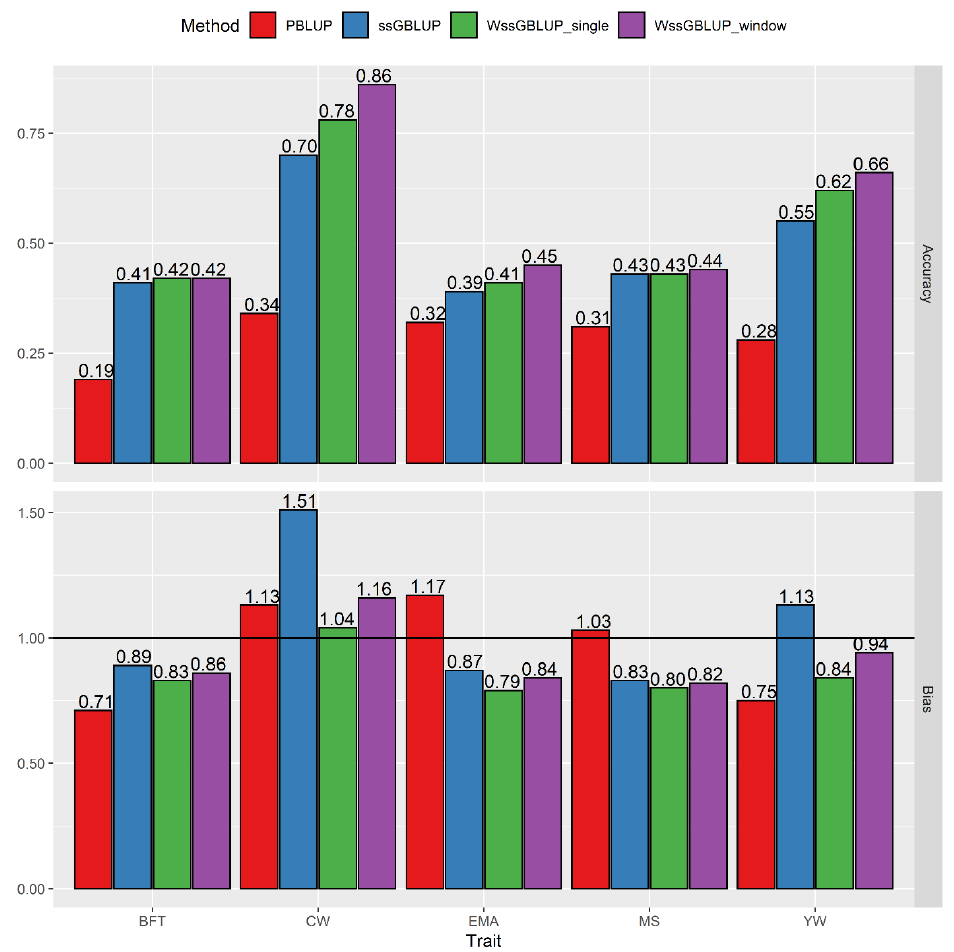
Figure 4. Prediction accuracy and bias of GEBV/estimated breeding value (EBV) obtained using pedigree-based best linear unbiased prediction (PBLUP), single-step genomic best linear unbiased prediction (ssGBLUP), and the best single and window weighting ssGBLUP (WssGBLUP) for the studied traits. BFT, backfat thickness; CW, carcass weight; EMA, eye muscle area; MS, marbling score; YW, yearling weight. The default method for CW and YW at the second iteration, the constant method for MS and EMA at iteration 2 and 5, respectively, and nonlinear A with CT value of 1.25 and limiting the maximum SNP variance of 5 (nonlinearA_1.25_5) at iteration 2 for BFT were the best single weighting WssGBLUP method. The summed window (window size = 75) for CW and YW at iteration 3, The largest window (window size = 75) for BFT and MS at iteration 2, and the largest window (window size = 100) at the third iteration for EMA were the best window weighting WssGBLUP